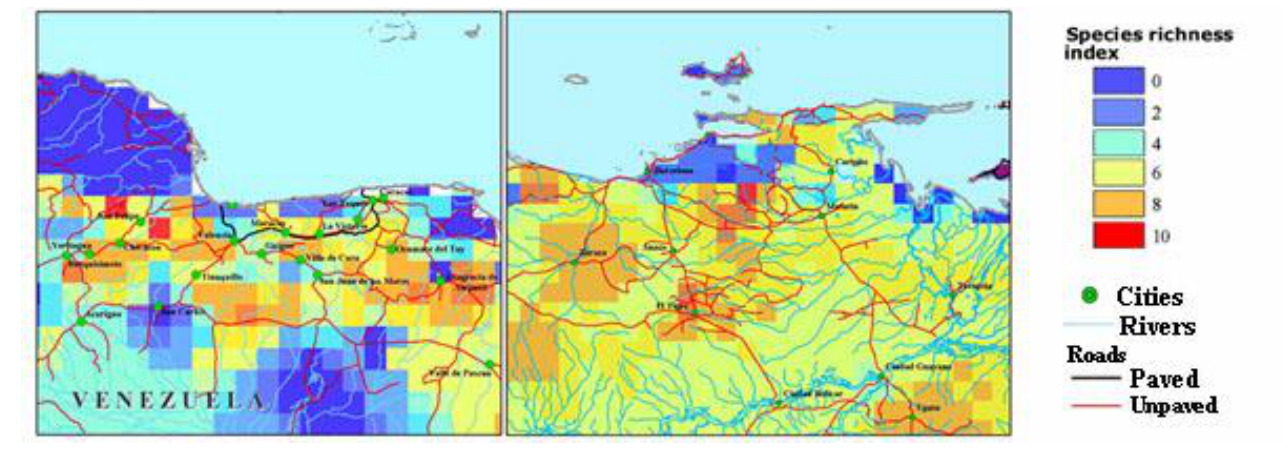
Fig. 8 . Details of selected area in